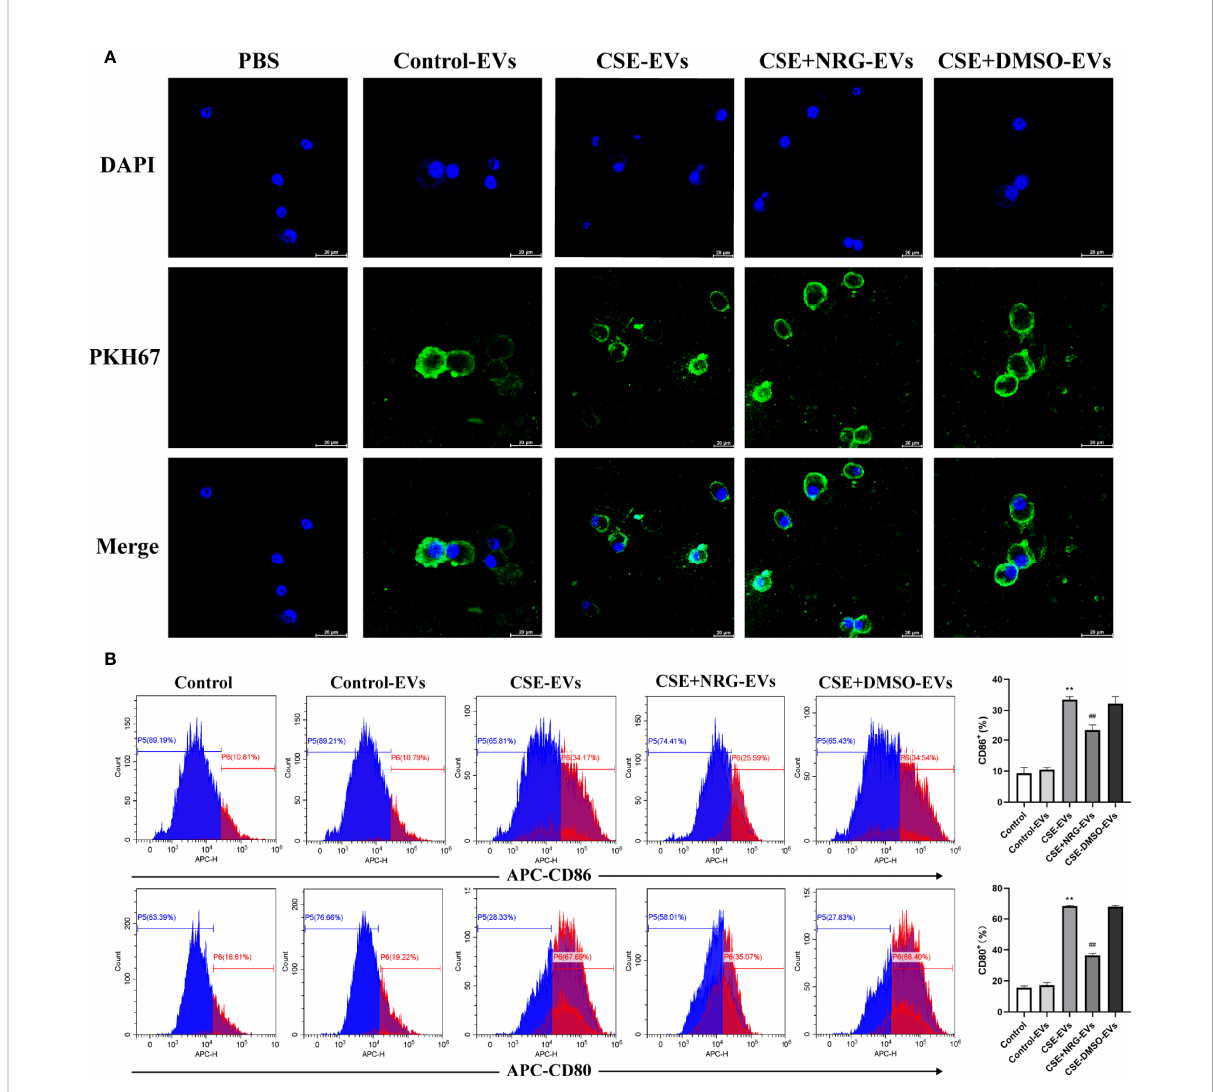
FIGURE 4 CSE+NRG-EVs suppressed M1 macrophage polarization of MH-S macrophages induced by CSE-EVs. (A) Uptake of BEAS-2B-derived EVs by MH-S macrophages imaged by confocal microscopy. Scale bar = 20 m m. (B) Representative fi gures showing the effects of different groups of EVs on M1 polarization. CSE+NRG-EVs signi fi cantly decreased the M1 rates of MH-S (n = 3). ** p <0.01 vs . Control-EVs group. ## p <0.01 vs . CSE-EVs